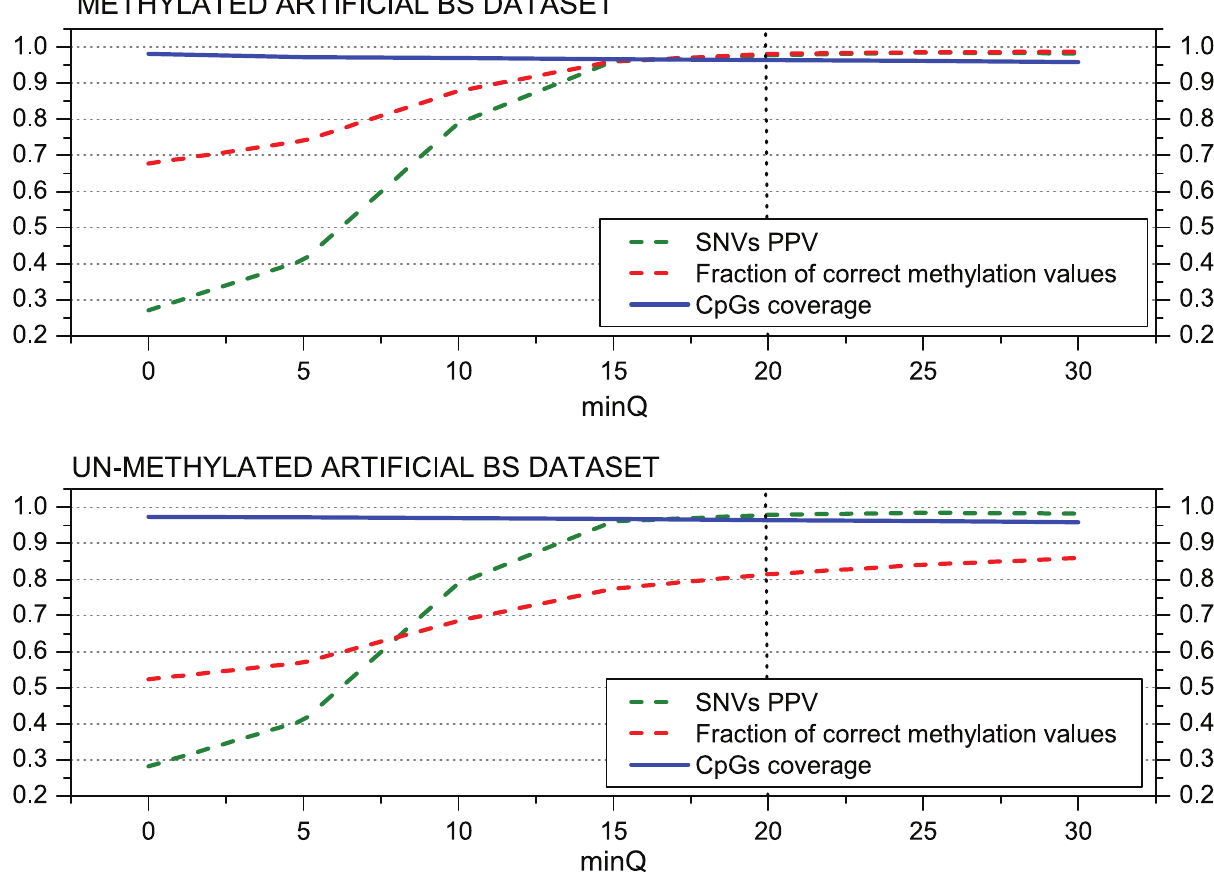
Figure 5. MethylExtract SNV calling and methylation profiling as a function of the base quality. Both graphs show the positive predictive value (PPV) for SNV calling and the fraction of correctly profiled CpG methylation values (methylation profiling) as a function of the minimum base quality (PHRED score parameter ‘minQ’). The graphs are based on the methylated (top) and un-methylated (bottom) artificial bisulfite datasets at a mean 20× read coverage. Y-axis represents SNV PPV, Fraction of correct methylation values and CpG coverage. All of them vary between 0 to 1 therefore being represented